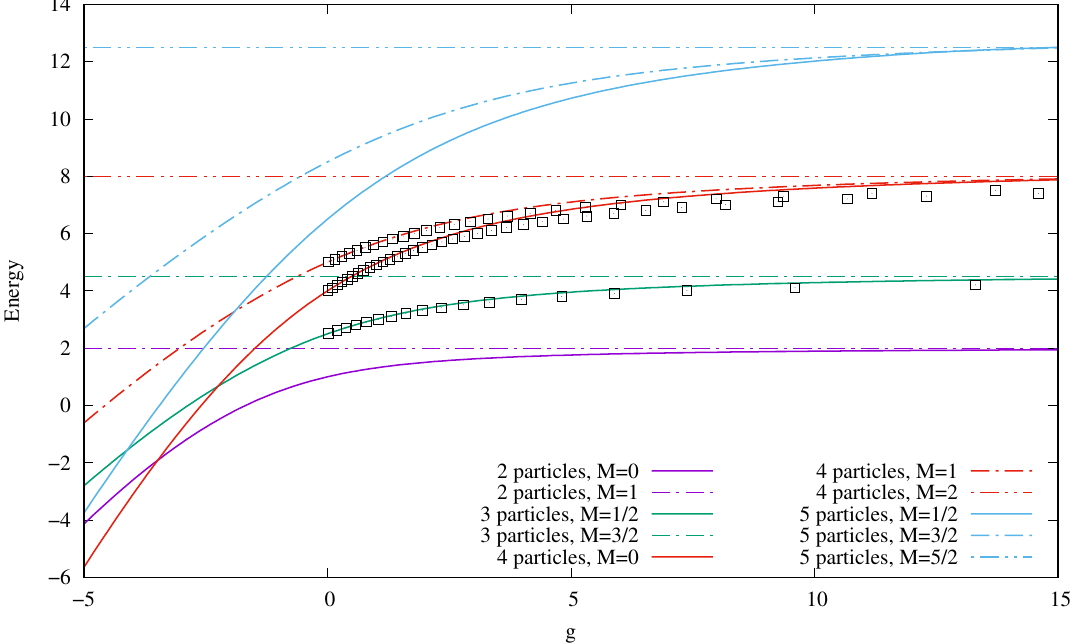
Figure 3. Ground-state energy as a function of the interaction strength for different number of particles and spin configurations. The calculations have been performed by using 100, 50, 40 and 30 single-particle modes to construct the many-body basis for N = 2,3,4 and 5 particles respectively. The black squares are the corresponding results reported in Ref.